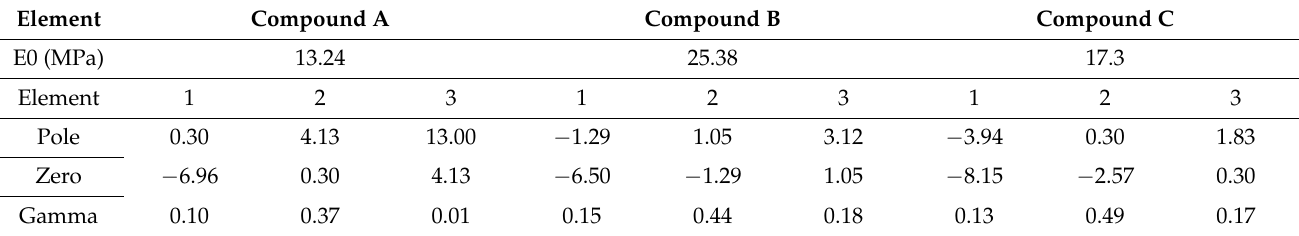
Table A1. Compounds A, B, and C: parameters of FDGM models composed of 3 elements.